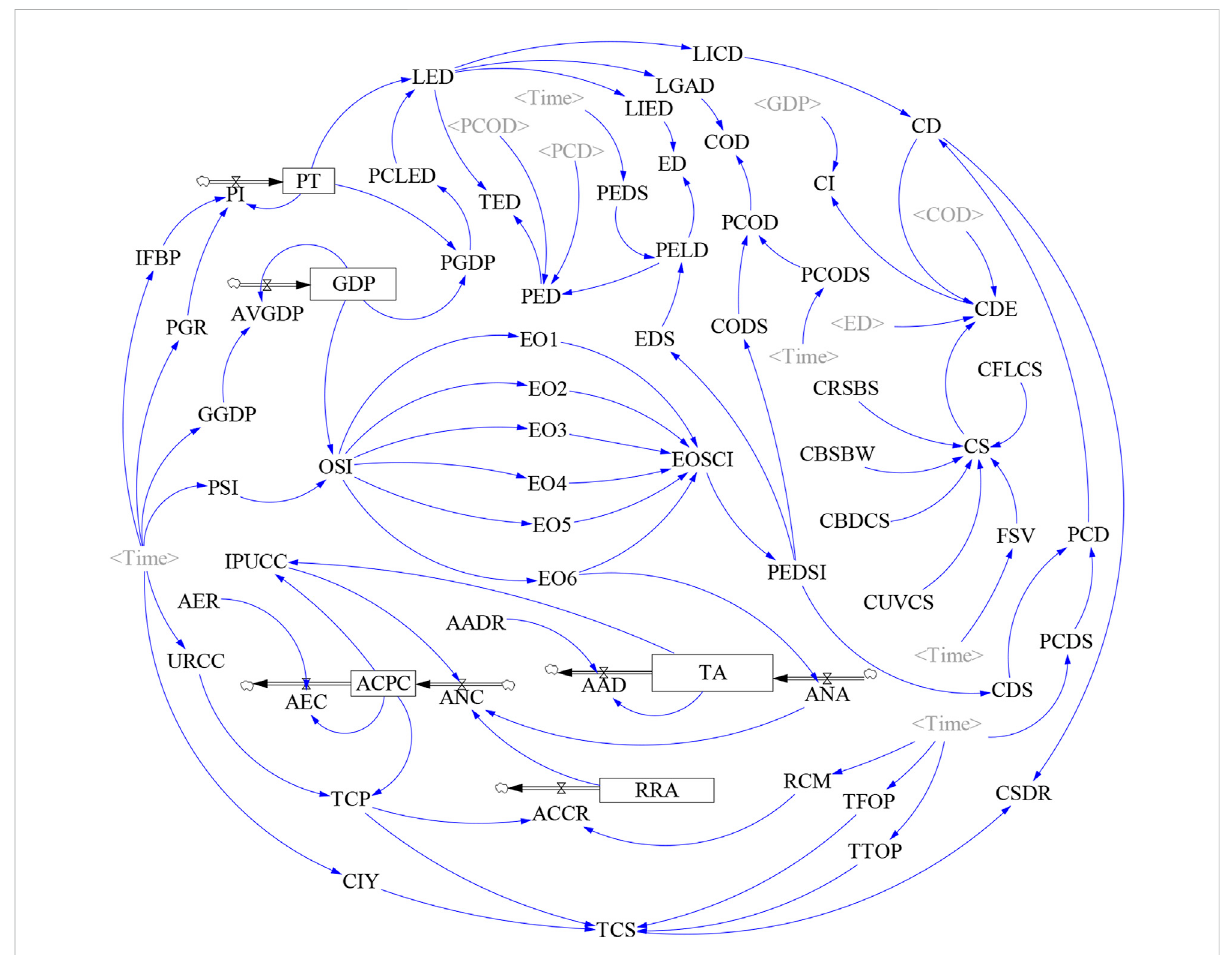
FIGURE 2 System dynamic fl ow diagram of coal demand in Shanxi